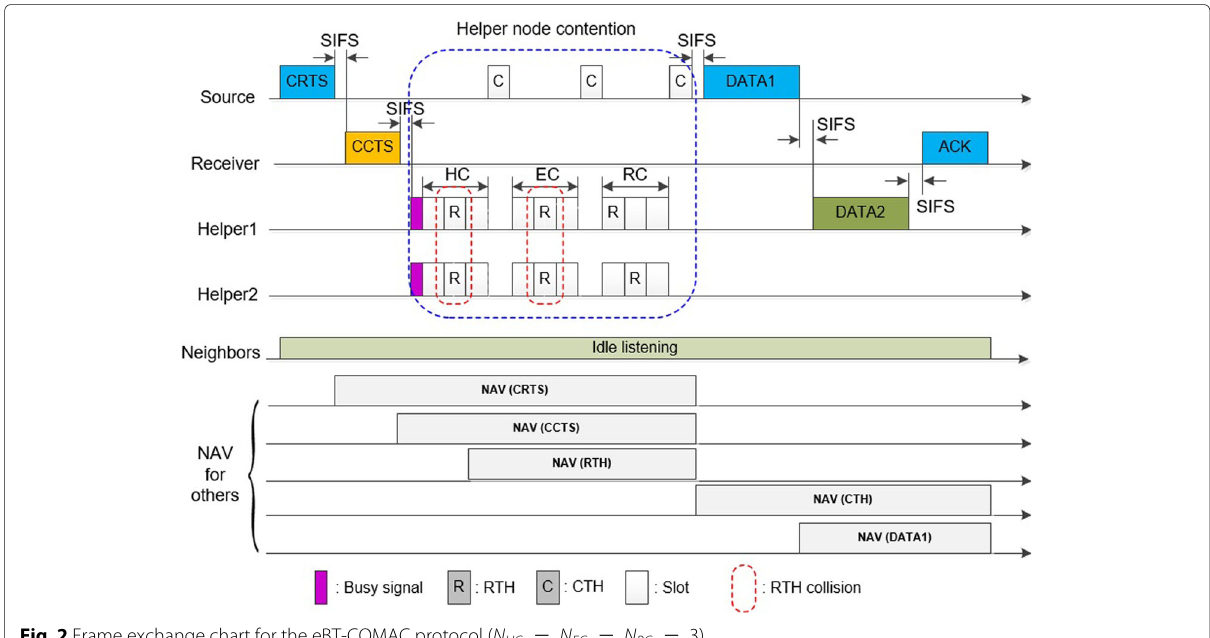
Fig. 2 Frame exchange chart for the eBT-COMAC protocol ( N HC = N EC = N RC =